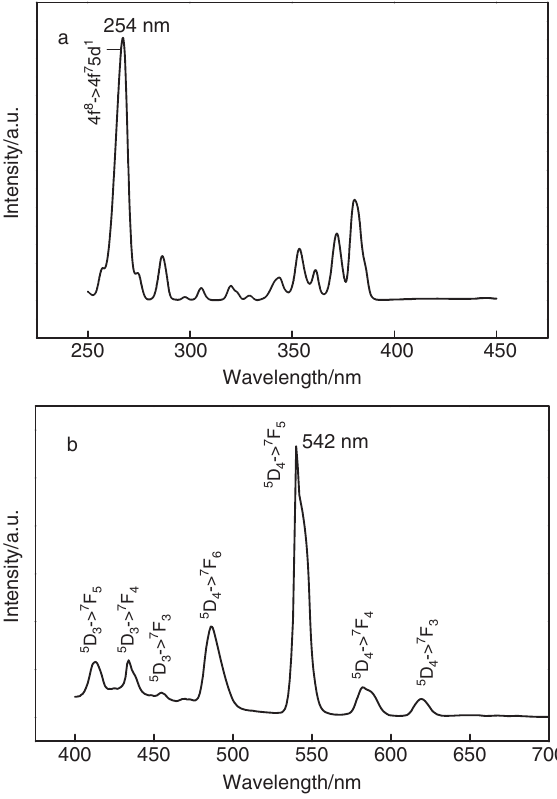
Figure 1: Excitation and emission spectra of 70ZnO – 10P 2 O 5 – 20SiO 2 – 5Tb 3 þ glass: (a) excitation spectra monitored with 542 nm and (b) emission spectra excited with 254 nm.